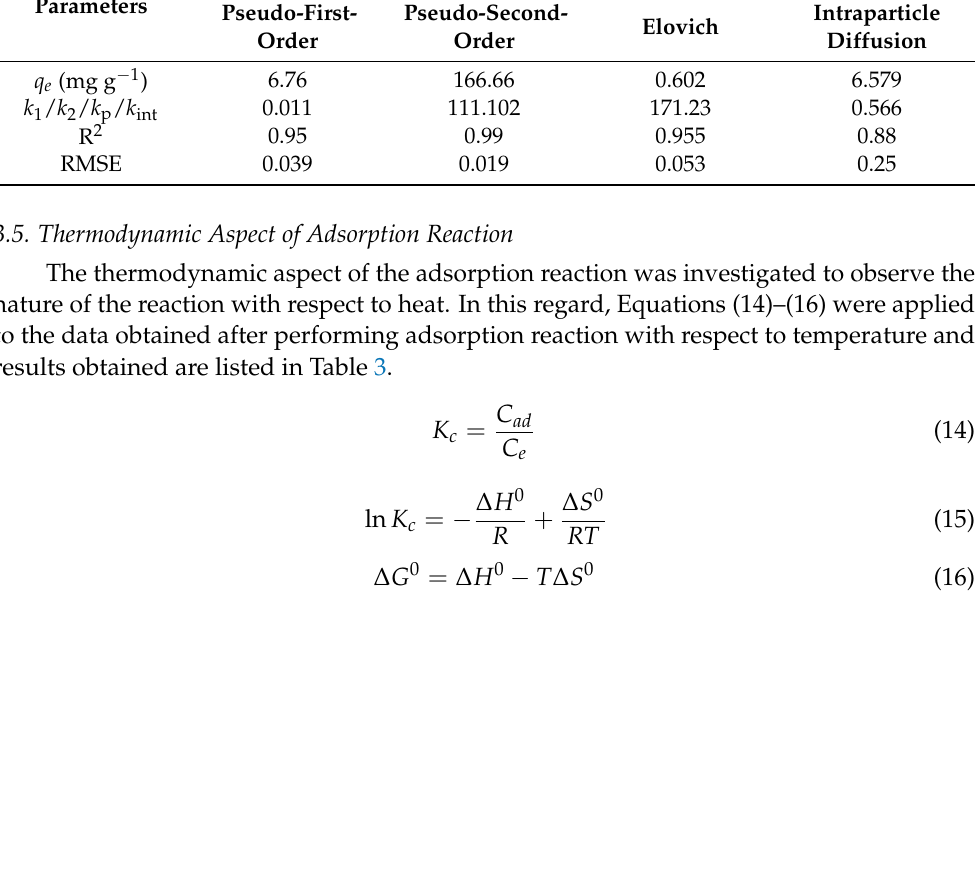
Table 2. Kinetic data obtained through linear regression for removal of Pb (II) by XGFO BNC at 323 K temperature. Kinetic Models Parameters Pseudo-First-